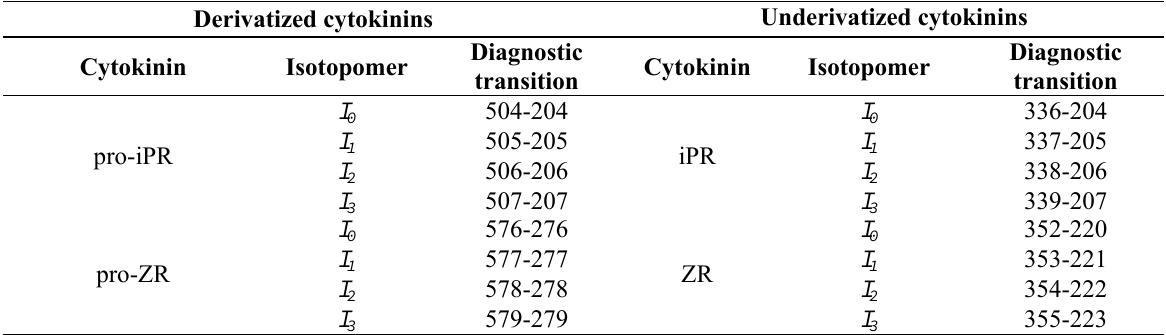
Table 3. Diagnostic transitions used to measure the rate of synthesis of selected